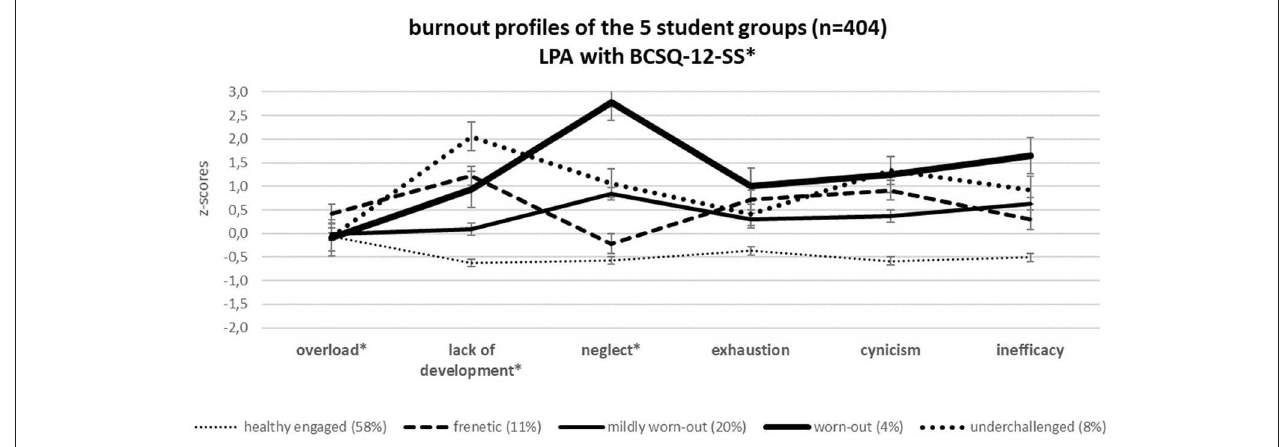
FIGURE 1 | Burnout characteristics of the five BCSQ-12-SS classes in the entire sample.